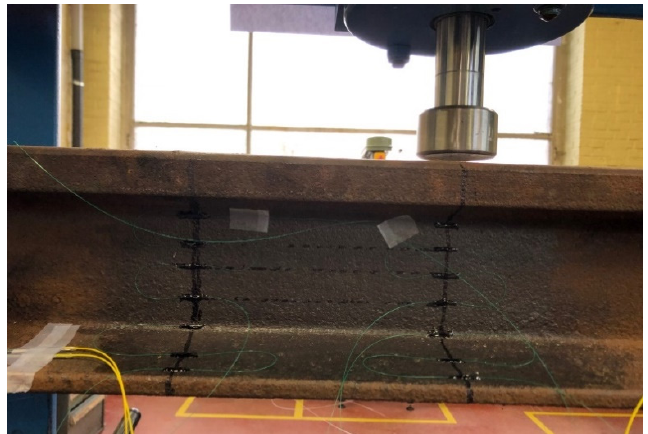
Figure 4 . Three-point bending test of a rail (type 50E2) section for which nine FBG sensors are glued at different positions of the cross-section.